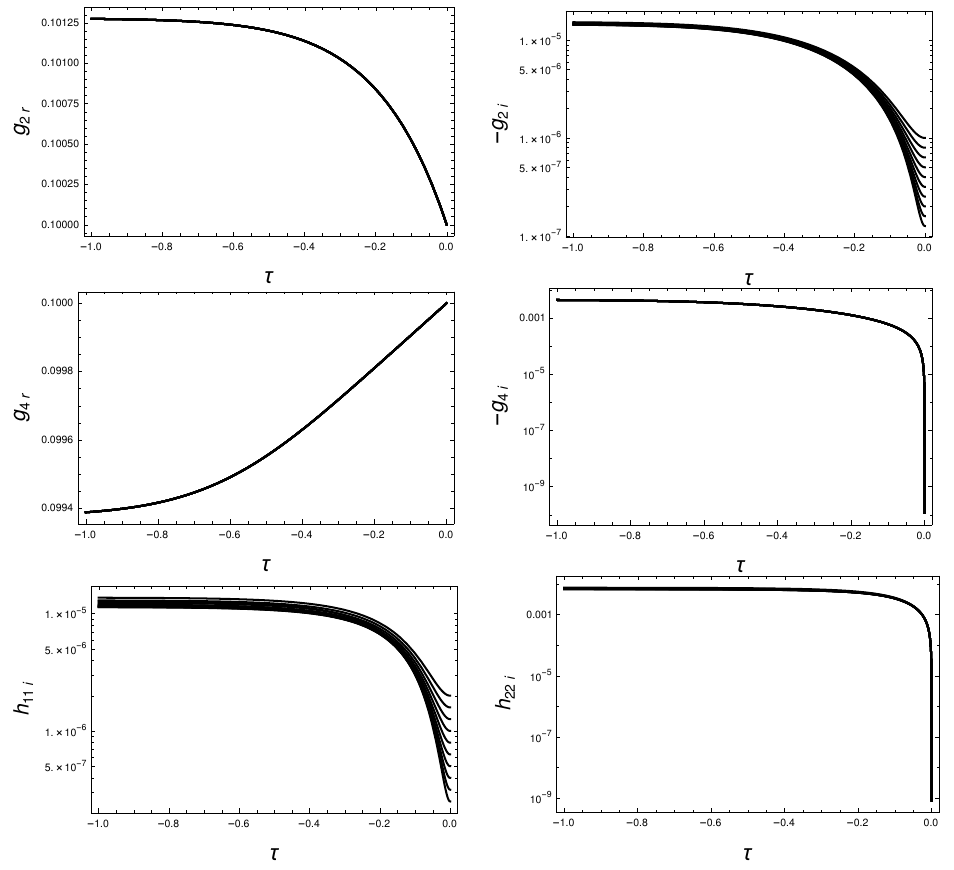
Figure 8. The closed limit, (cid:101) → 0, followed in the interval − 10 − 6 < (cid:101) < − 10 − 7 in the symmetric phase at g 2 ( Λ ) = 0.1 − i (cid:101) , g 4 ( Λ ) = 0.1, h 11 ( Λ ) = − i 2 (cid:101) , h 22 ( Λ ) = 0, η =